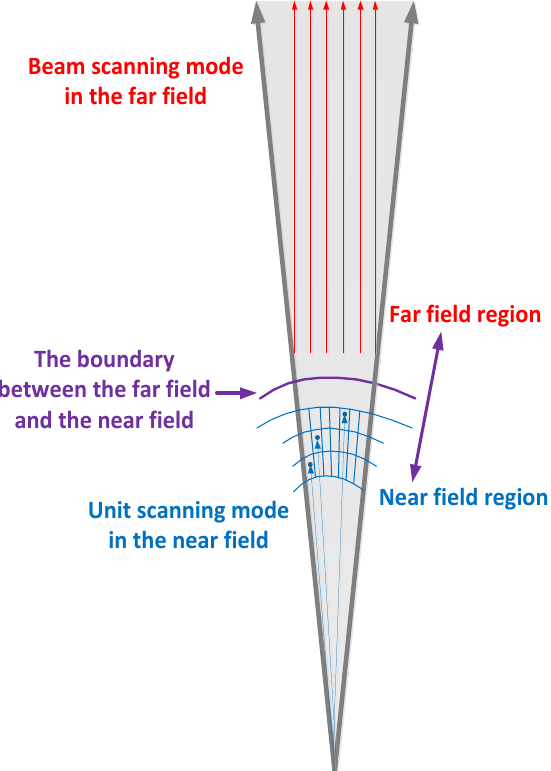
Figure 2. The target searching diagram of coherent radar in the whole field.